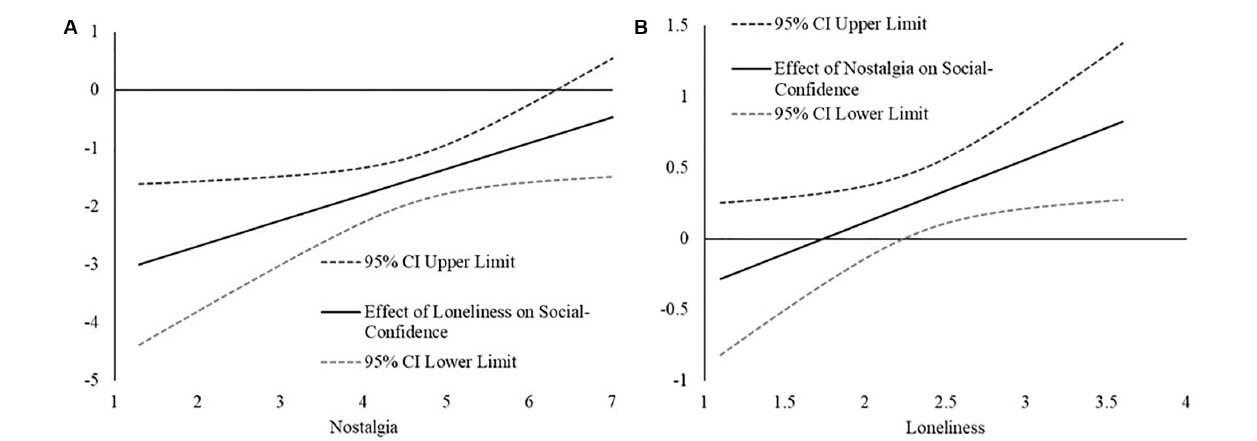
FIGURE 1 | (A) The plot represents the estimated relation between loneliness and social confidence ( y -axis) across the range of nostalgic feelings ( x -axis) in Study 1. The relations are considered statistically significant if the confidence intervals for the effect (CI) do not contain 0. (B) The plot represents the estimated relation between nostalgic feelings and social confidence ( y -axis) across the range of loneliness scores ( x -axis) in Study I. The relations are considered statistically significant if the confidence intervals for the effect (Cl) do not contain